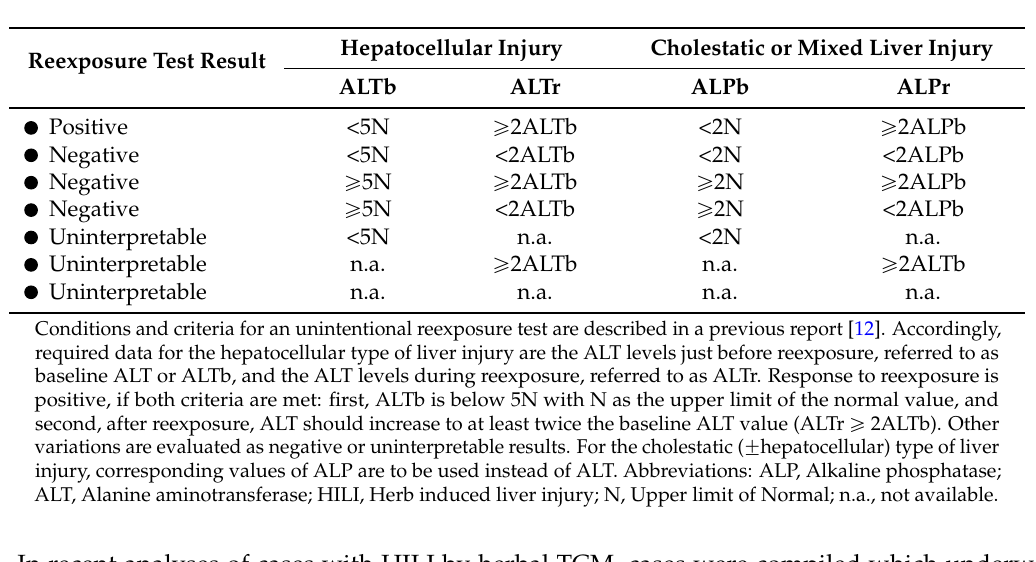
Table 8. Conditions of unintentional reexposure tests in HILI